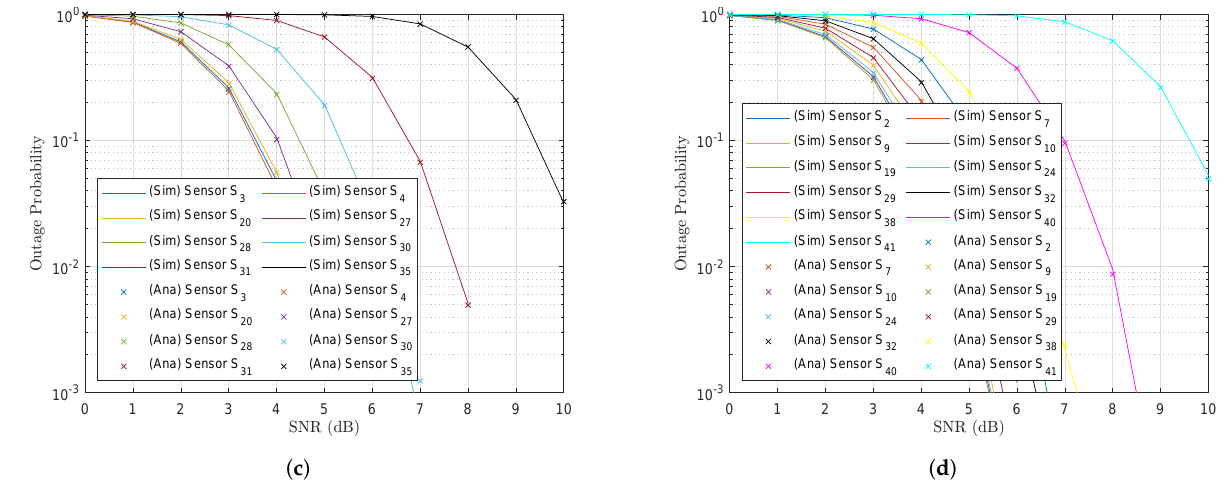
Figure 9. Improved outage probability at the mobile base station equipped with A B = 32 antennae for the UAV trajectory subcluster sequence ( a ) C 1 , ( b ) C 3 , ( c ) C 4 and ( d ) C 2